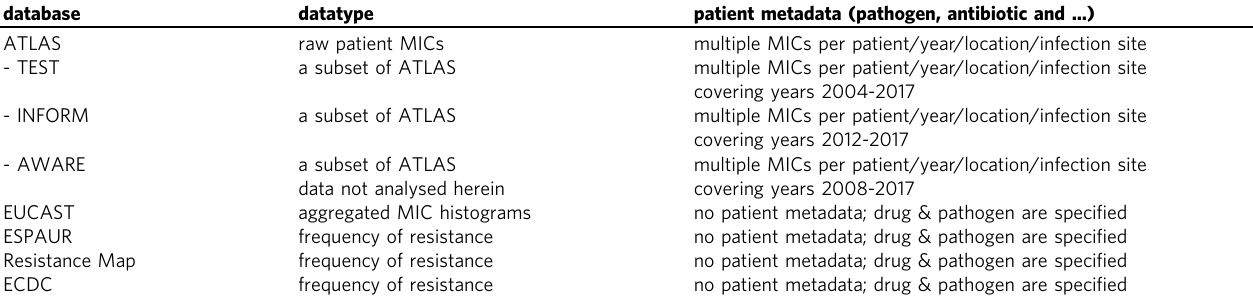
The acronyms used are: ATLAS (Antimicrobial Testing Leadership and Surveillance), EUCAST (the European Committee on Antimicrobial Susceptibility Testing), ECDC (European Centre for Disease Prevention and Control) and ESPAUR (English Surveillance Programme for Antimicrobial Utilisation and